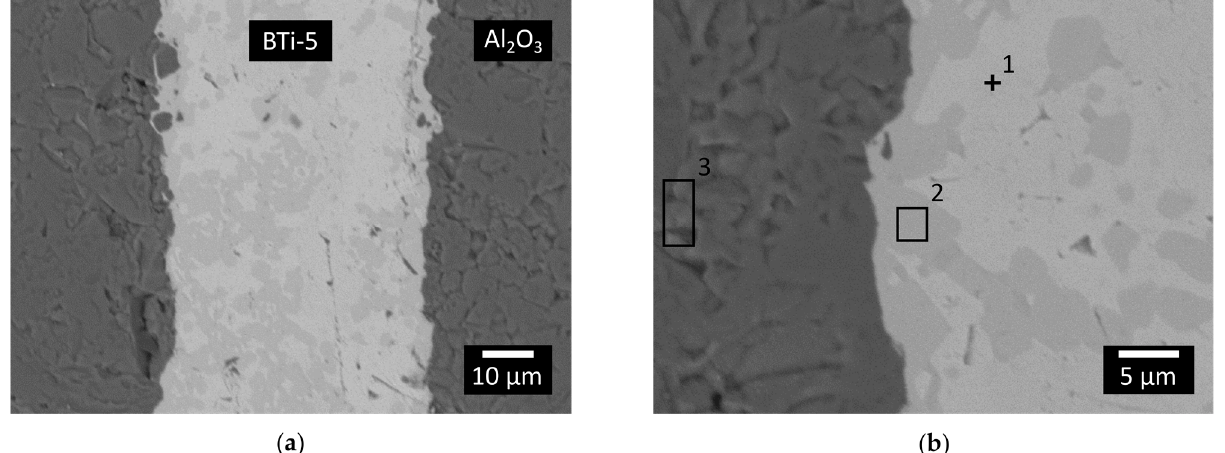
Figure 7. ( a ) SEM-BED images of the cross-section of the planar joining between the two blocks of Hastelloy C22 ® produced at 900 °C for 12 min in a high vacuum furnace and 750 °C for 20 min, with ( b ) an enlargement of the joining interface. An EDS was performed in this area, and the analyzed points and areas are shown in the picture. Table 4. Composition (at %) measured by means of the EDS analysis of the points and areas indi- cated in Figure 7b.